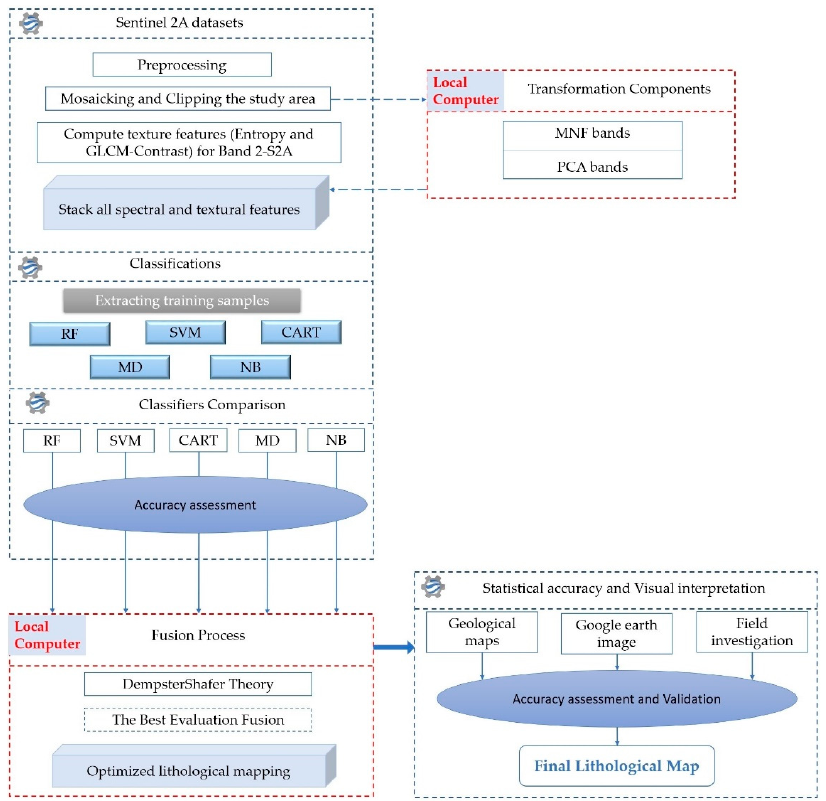
Figure 2. Methodological workflow of the current study within GEE platform and local computer.